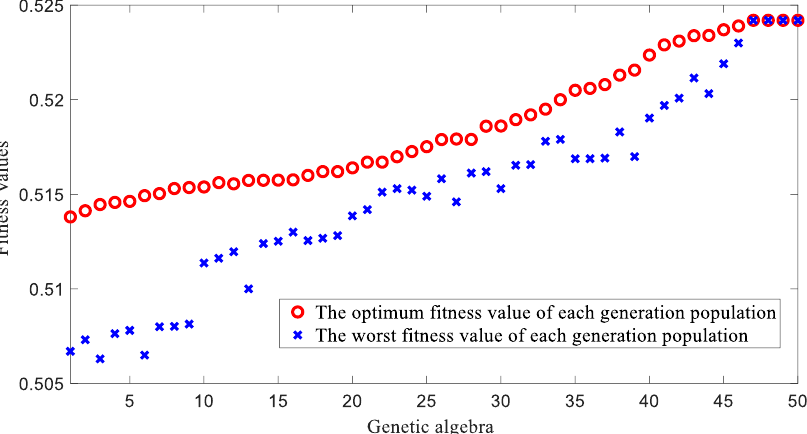
Figure 14. The 50 generations of population fitness values. Through the optimization results in Figure 14, the optimal chromosome, i.e., optimal braking sequence is obtained as shown in Figure 15. It means that braking according to the gene sequence of this chromosome can obtain the most BERE within the constraints. Figure 15. The optimal chromosome. 0.25